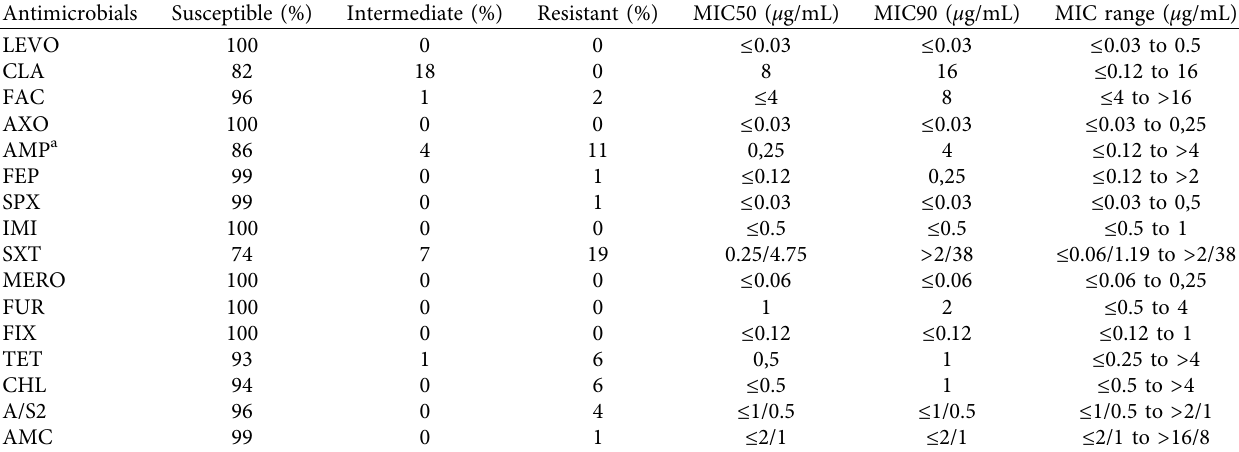
Table. 2: Antimicrobial susceptibility of H . influenzae isolated from nasopharynx of school children with AOM. Antimicrobials Susceptible